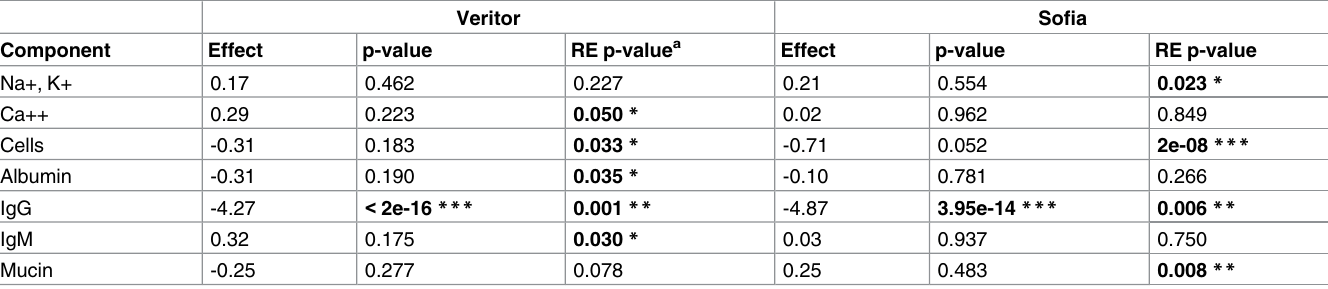
Table 3. Mean effect and p-values for the fractional factorial testing for the RATs. Veritor